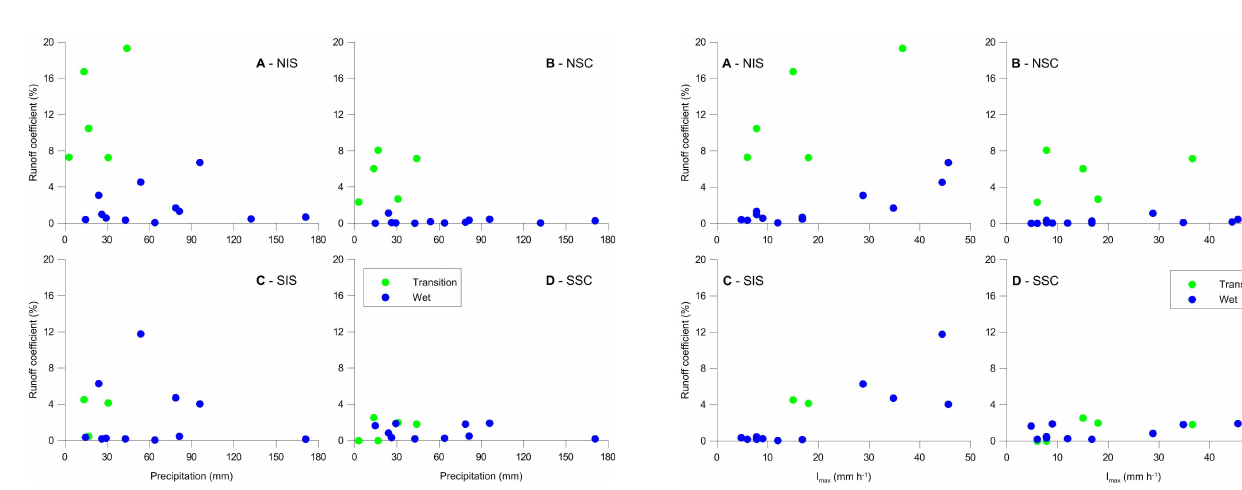
Fig. 6. Relation between runoff coefficient and I max . NIS: north- facing inter-shrub; NSC: north-facing shrub-covered; SIS: south- facing inter-shrub; SSC: south-facing